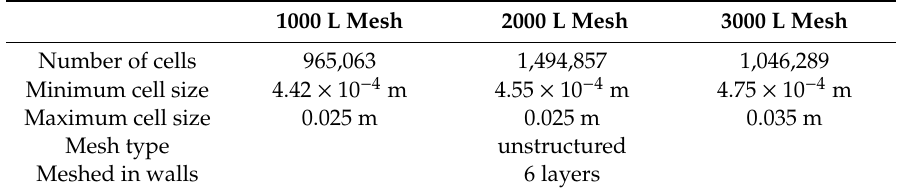
Table 1. Characteristics of the computational fluid dynamics (CFD) mesh models developed.